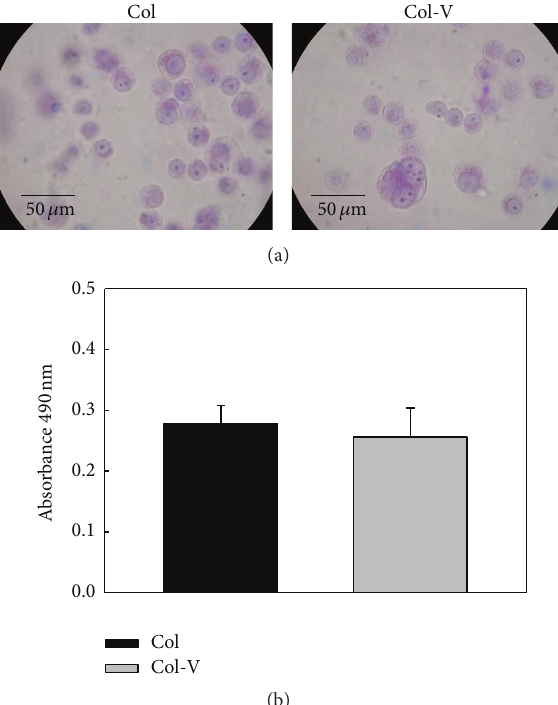
Figure 7: Cytotoxicity studies with RAW 264.7 macrophages. (a) Cells were cultured for 24h on Col or Col-V (20 𝜇 g/mL per cm 2 VOAsc) scaffolds, stained with Giemsa and photographed. (b) An MTT assay was performed to evaluate cell survival of BMPC growing on Col or Col-V scaffolds. Results represent the mean ±